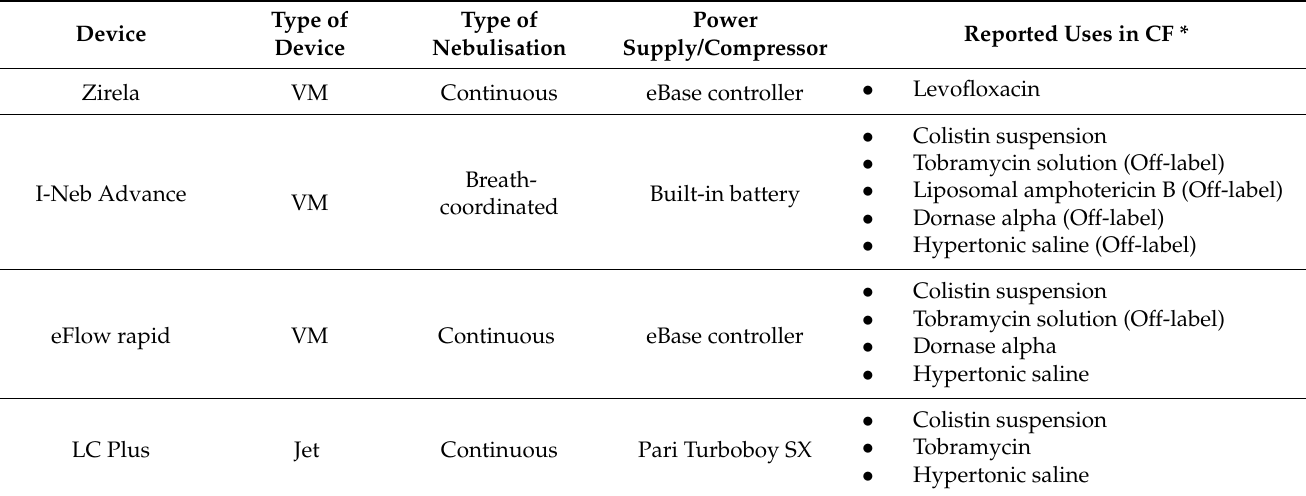
Table 2. Device characteristics and reported uses in Cystic